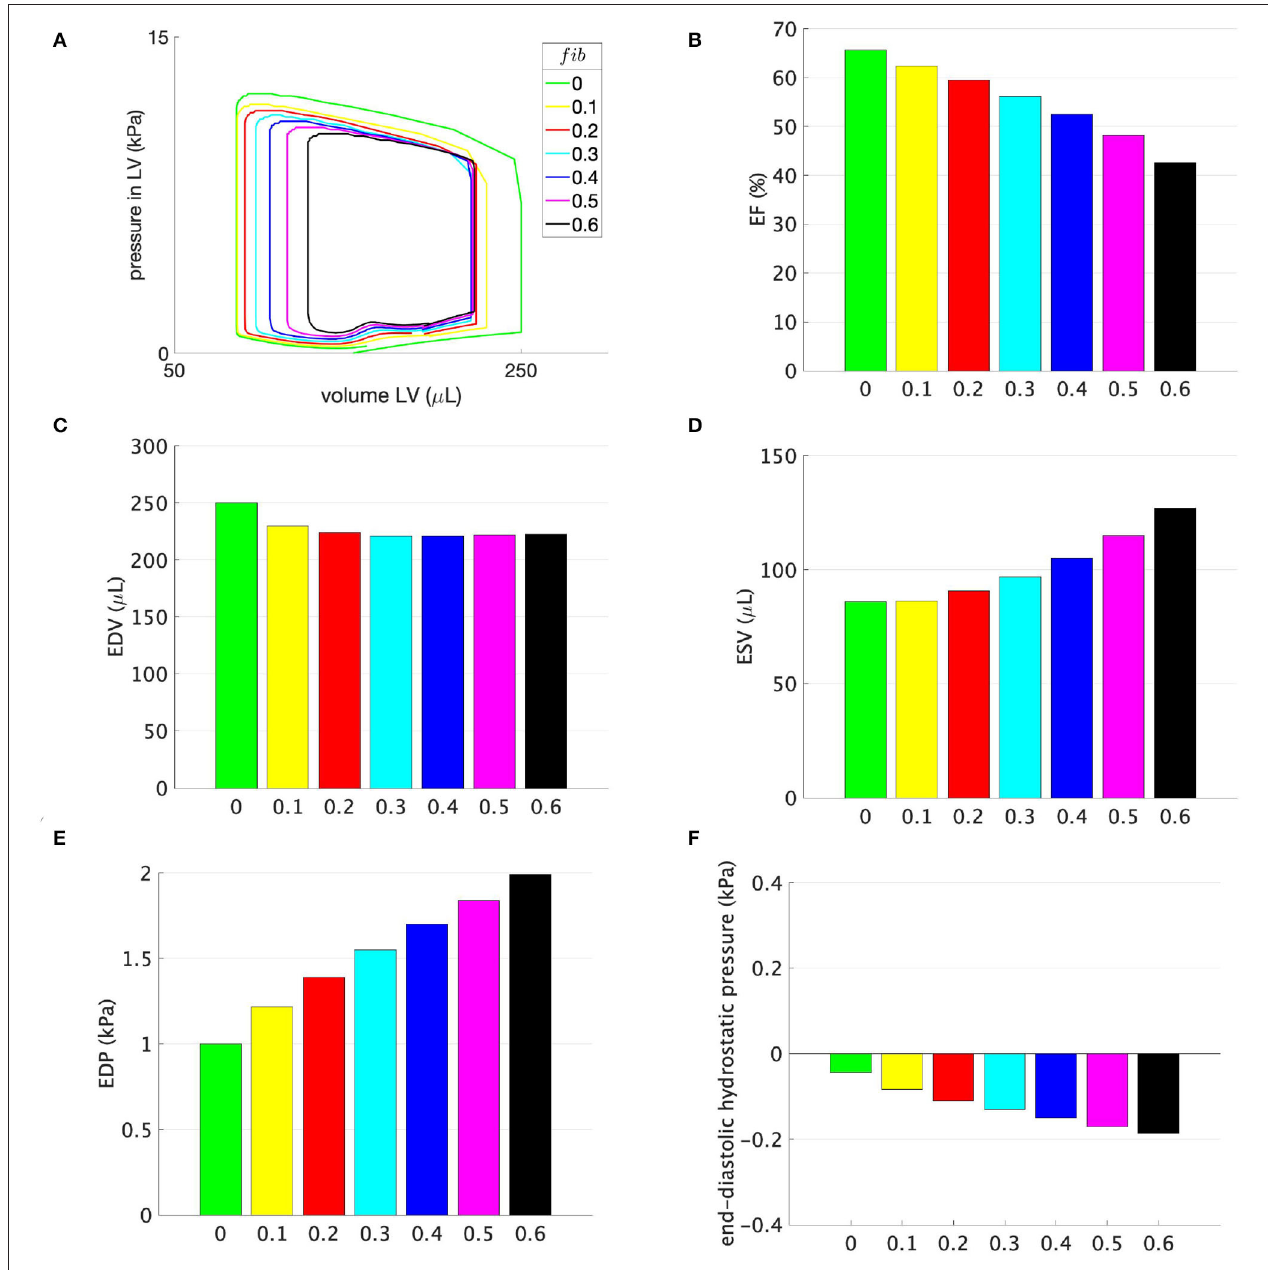
( Figure 4D ) is marginal and only sufficient for the case fib = 0.1. Therefore, higher systolic support pressure is needed in order to reduce the ESV and eventually increase the EF, which is significantly below that of the control rat for higher amounts of fibrosis. For example, the resulting EFs are 61.1%, 55.2% for fib = 0.3, 0.5, respectively, compared to the control rat with EF =